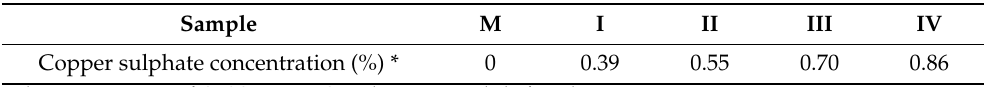
Table 1. The composition of hydrogel samples.